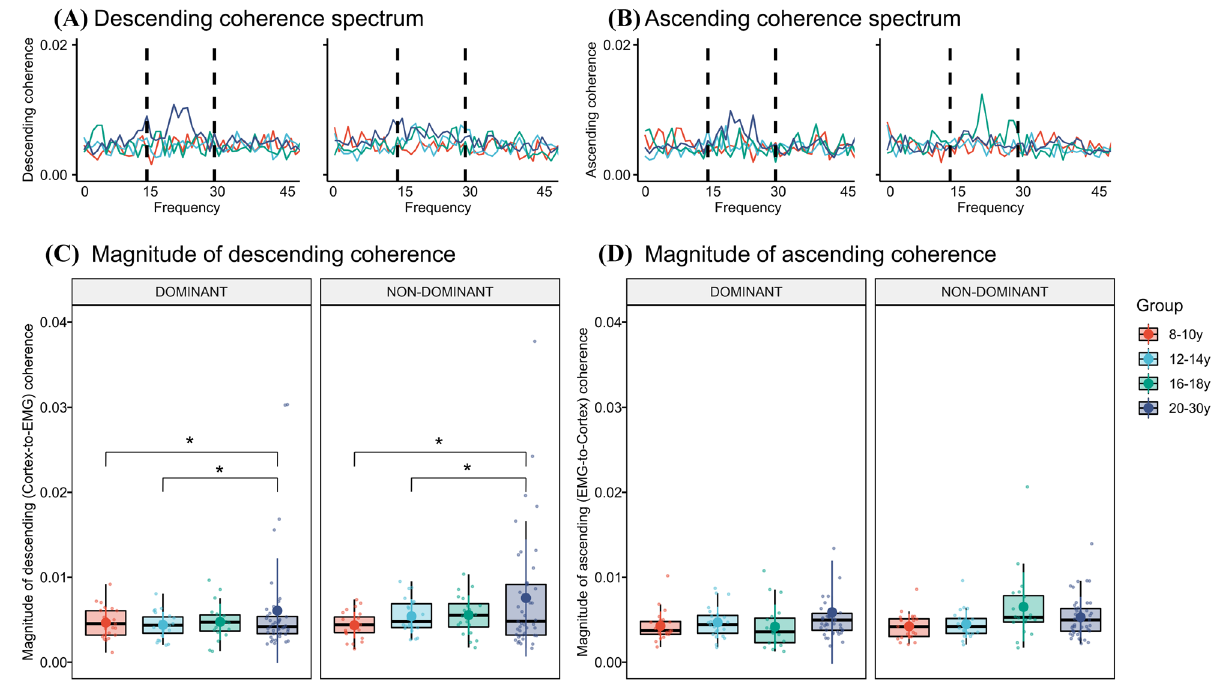
Figure 5. Directed corticomuscular coherence. Group-averaged coherence spectra for the descending ( A ) and ascending ( B ) components of coherence on the dominant (left spectrum) and non-dominant (right spectrum) hand. Box plots with individual data points and mean level displaying age-related differences in the descending ( C ) and ascending ( D ) amplitudes of beta-band corticomusclar coherence between cortical source and active FDI muscles on the dominant and non-dominant hand. Statistical significant differences from the 8–10 y group is marked by * (p <